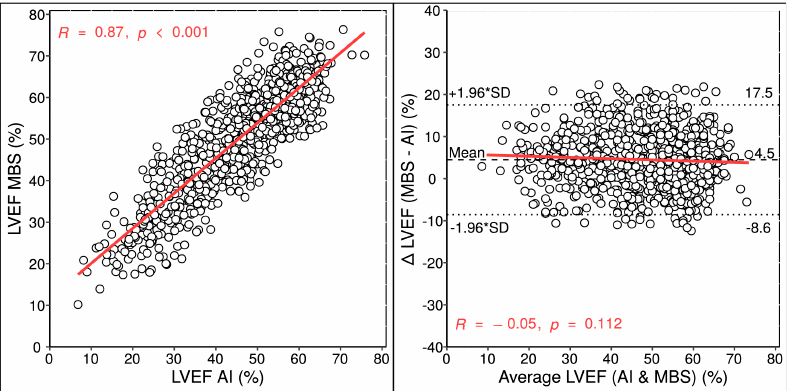
Figure 2. LVEF Validation among the AI-based Application and MBS Method ( N = 889). Correla- tion ( left ) and Bland–Altman analyses ( right ) of the LVEF between the AI-based application and MBS technique with mean values (dashed horizontal lines) and upper and lower limits of agreement (dotted horizontal lines), denoted as ±1.96 * standard deviation (SD). R denotes Pearson’s correlation coefficient with corresponding significance value p . AI = artificial intelligence; LVEF = left ventricular ejection fraction; MBS = modified biplane Simpson. Table 2. Comparison of Measurement Results between AI and MBS ( N = 889).